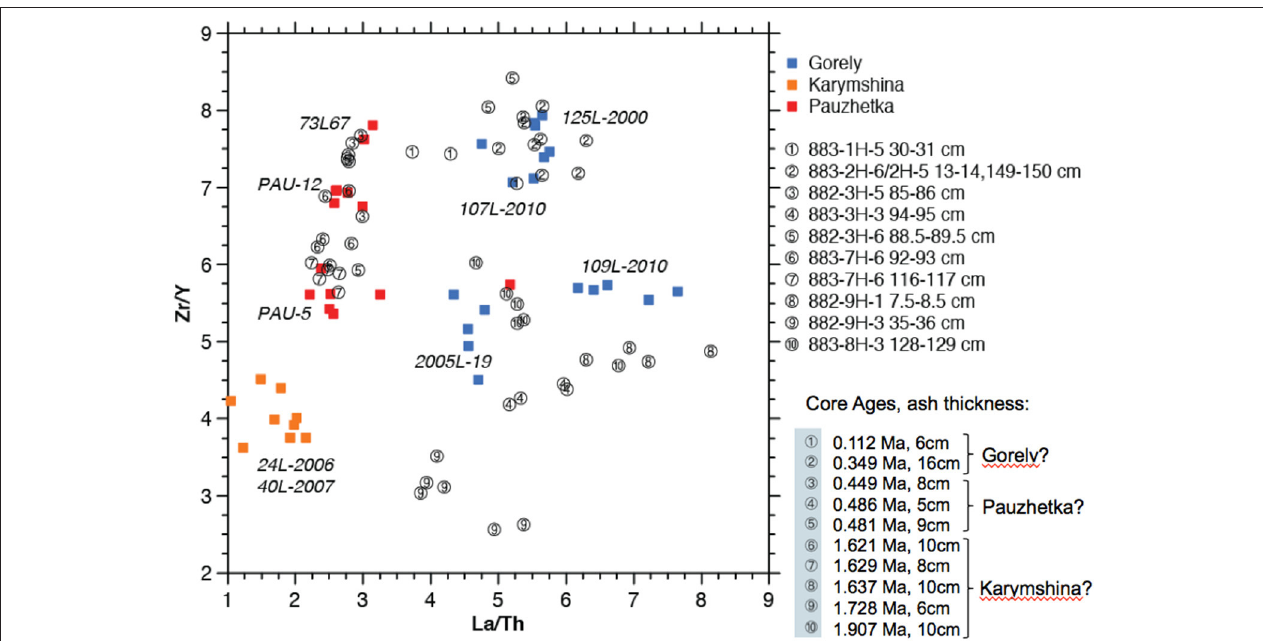
FIGURE 12 | Trace elemental ratio diagram comparing interstitial glass in the 1.78Ma Karymshina ignimbrite and other studied Kamchatkan tephras as compared to the Pacific cores ODDP-882 and 883. Note the match of Pauzhetka and Gorely tephra layers but lack of match for Karymshina. Age and ash thickness data is from Prueher and Rea (2001). See text for discussion and Table A2 for analyses of analyzed tephras.